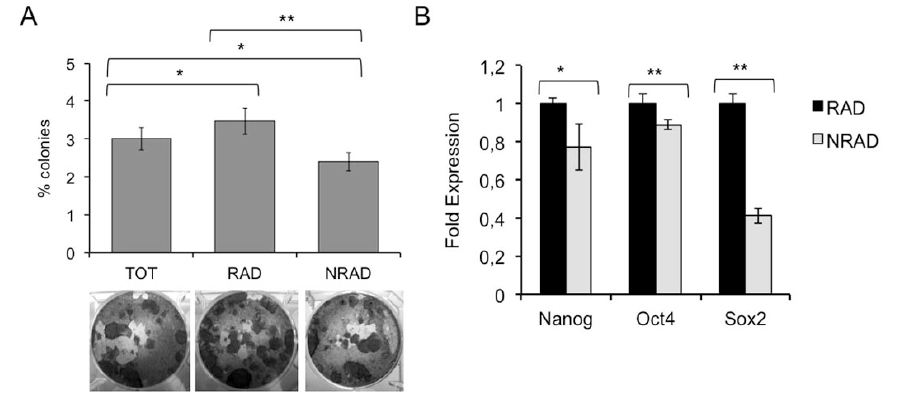
Figure 4. Analysis of stem-cell features in RAD and NRAD cells in vitro . ( A ) Clonal growth assessment of cSCC subpopulations by CFE. CFE was performed in triplicate in three independent experiments and quantification is shown in the upper panel. At the bottom, representative pictures of CFE obtained by growing cells at clonal density and stained with CV are shown; ( B ) mRNA expression of Nanog, Oct4 and Sox-2 by Real Time PCR. The different levels of gene expression in RAD vs. NRAD cells are shown. * p < 0.05; ** p <